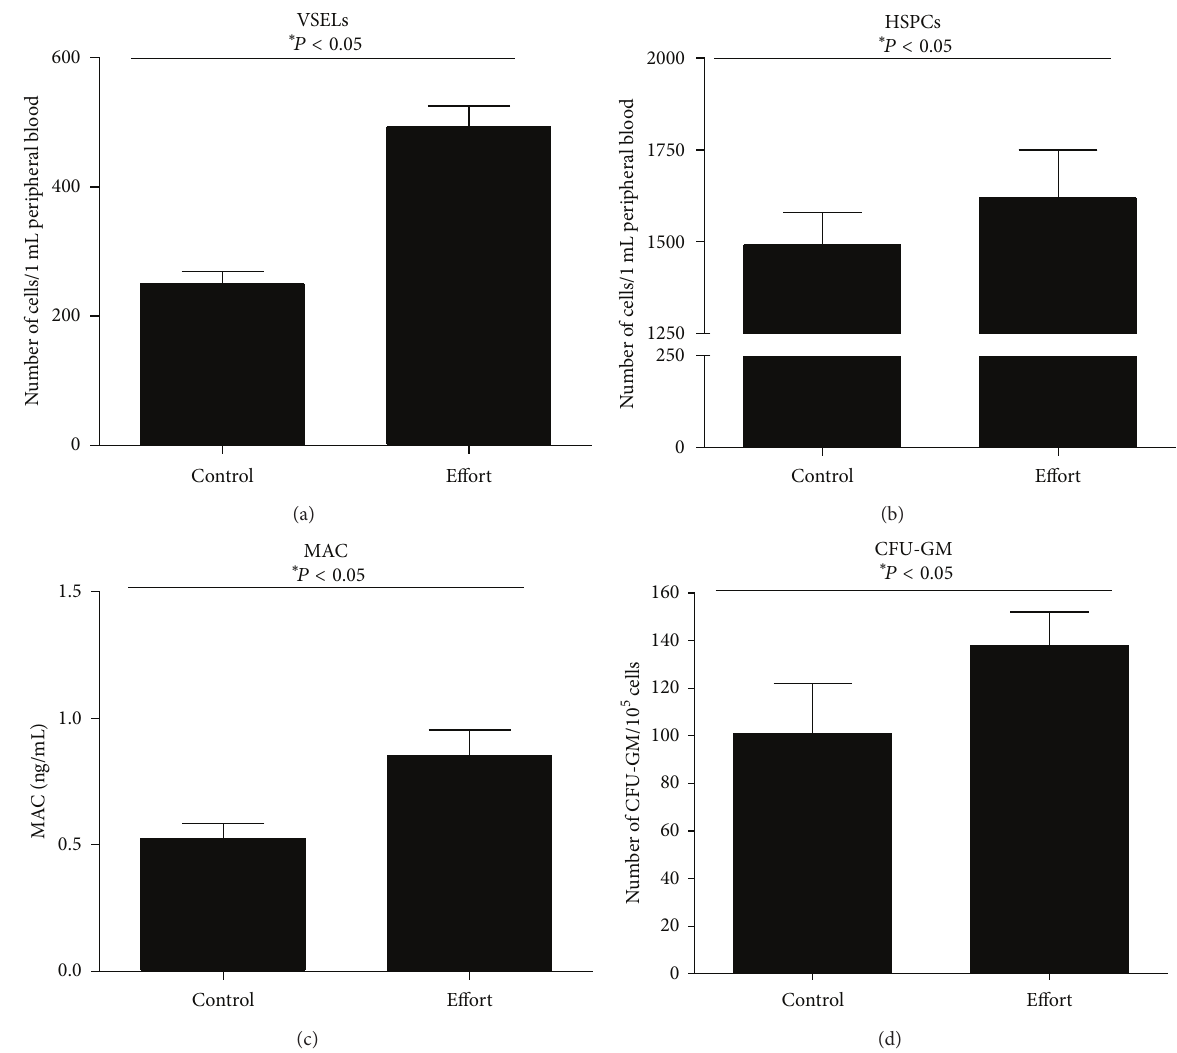
Figure 1: Effect of short (45min) exercise on a rotating wheel on stem cell mobilization in mice. (a, b) The number of VSELs (a) and HSPCs (b) circulating in PB after 45 min of exercise on a rotating wheel (effort) compared with nonexercising mice (control). (c) Activation of the complement cascade in PB after 45 min of exercise on a rotating wheel (effort) compared with nonexercising mice (control) measured by C5b-C9 (MAC) ELISA. (d) The increase in the number of clonogenic progenitors circulating in PB after 45 min of exercise on rotating wheels (effort) compared with nonexercising mice (control) ( 𝑛 = 6